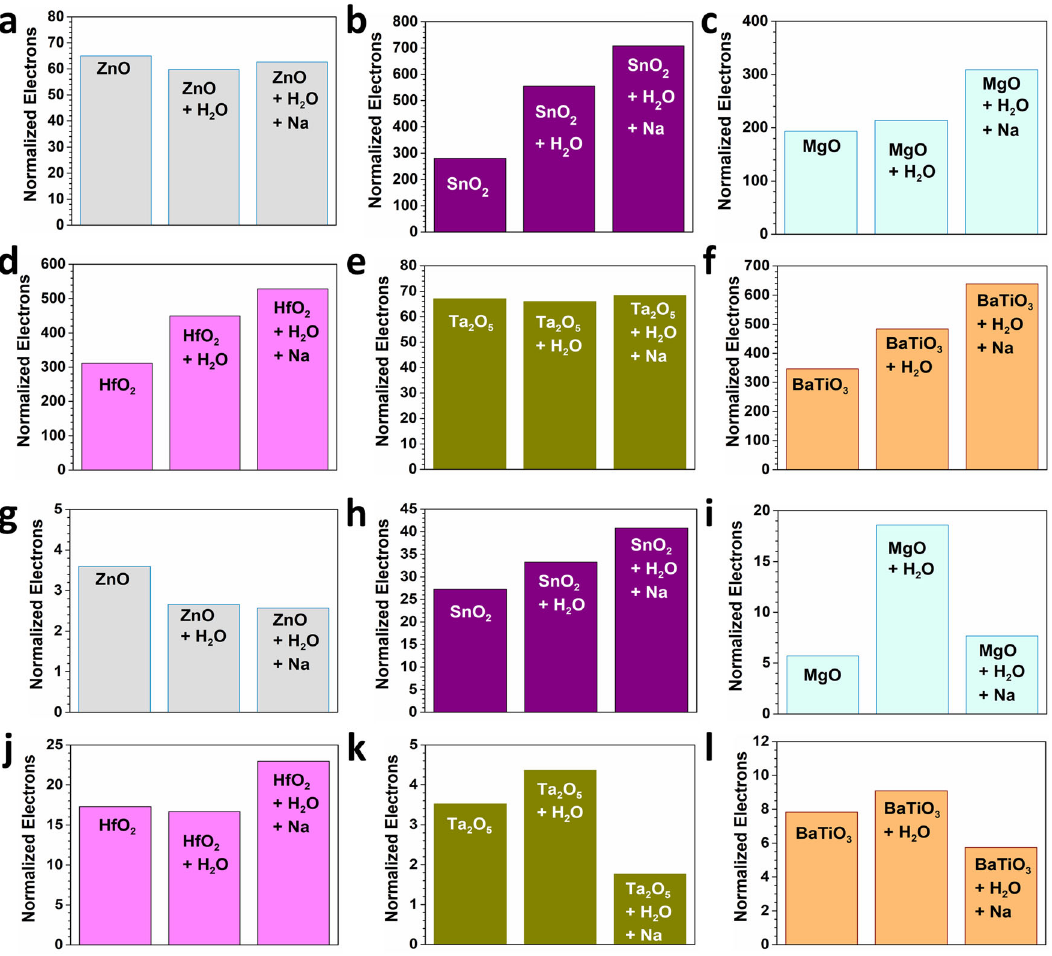
Fig. 4 The normalized electron numbers of the valence band for different solids in contact with water and solution. a ZnO, b SnO 2 , c MgO, d HfO 2 , e Ta 2 O 5 , and f BaTiO 3 . The normalized electron numbers near the Fermi level for different solids in contact with water and solution. g ZnO, h SnO 2 , i MgO, j HfO 2 , k Ta 2 O 5 , and l BaTiO 3